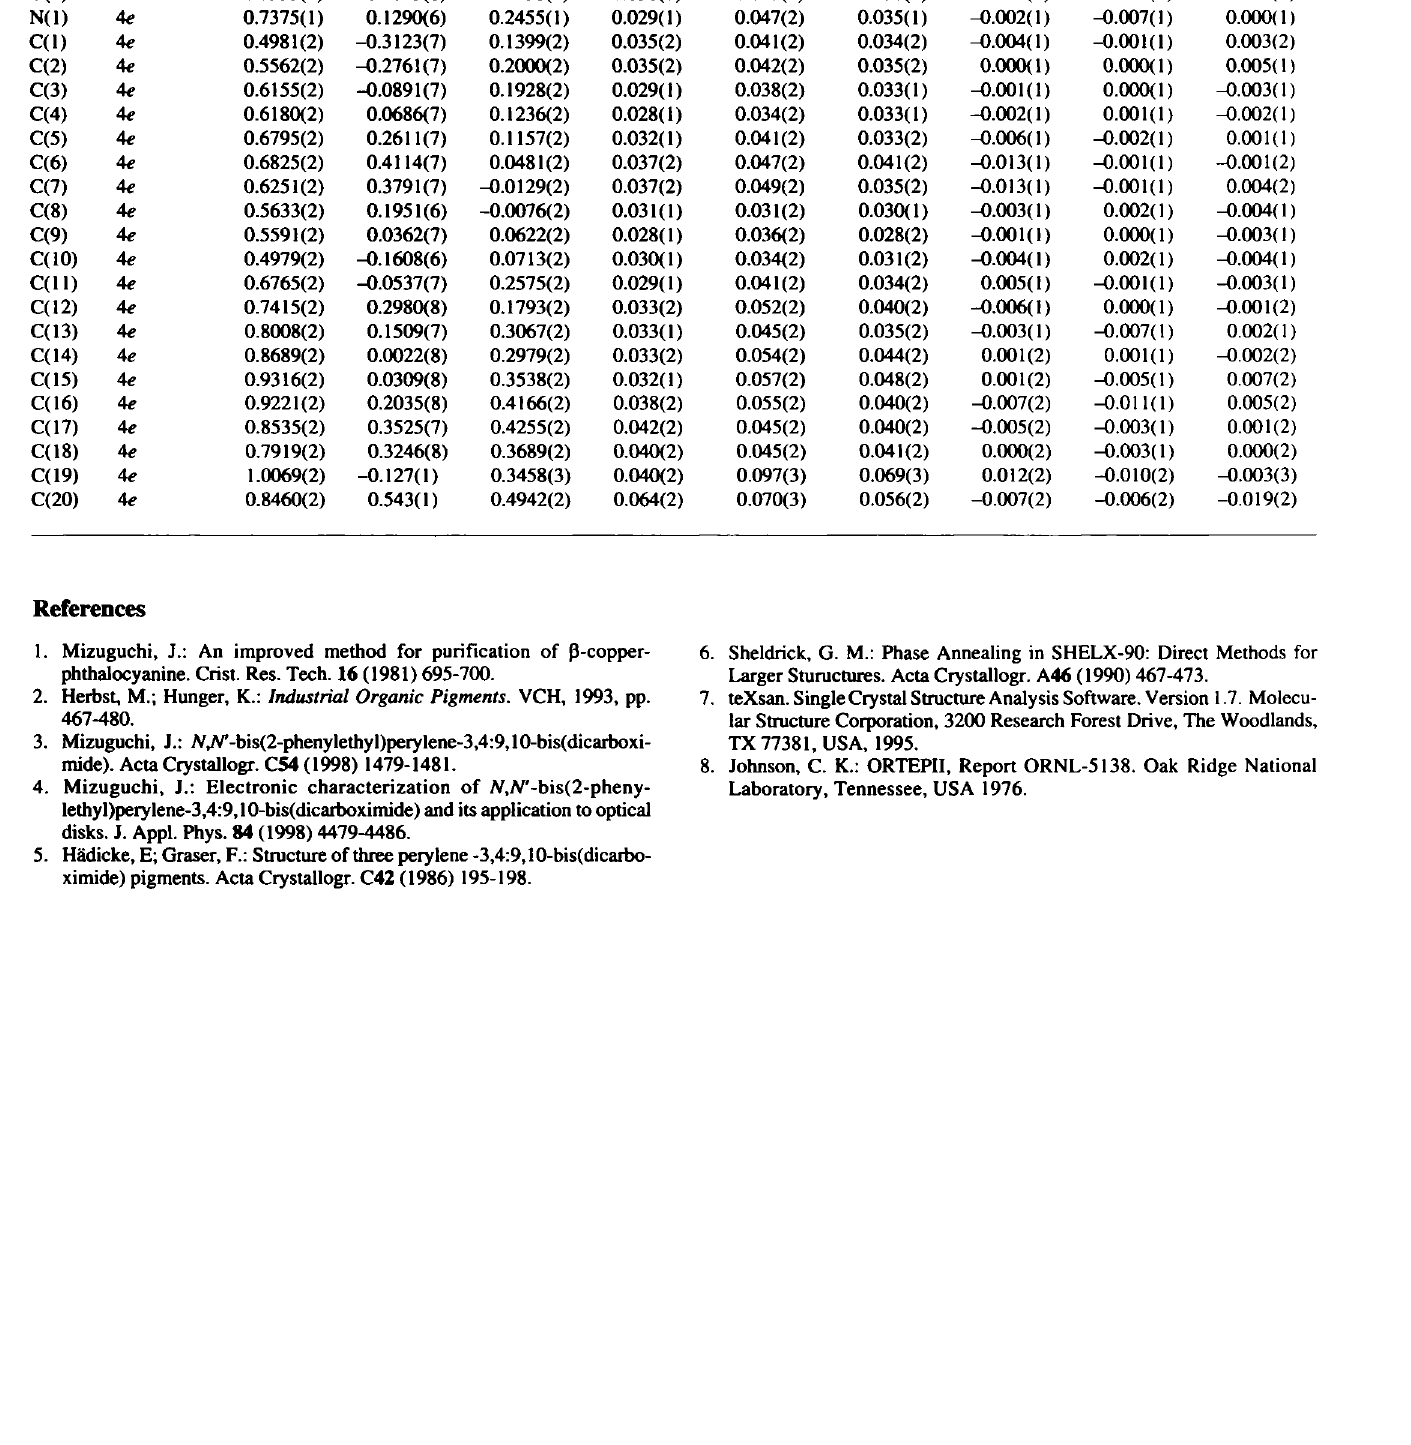
Table 3. Atomic coordinates and displacement parameters (in A 2